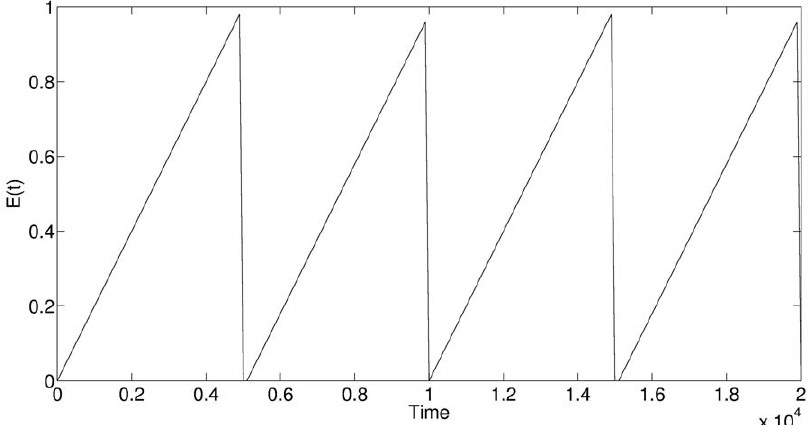
Figure 1. An artificial environment used by the agent based model. E ( t ) represents the environmental value at time t .